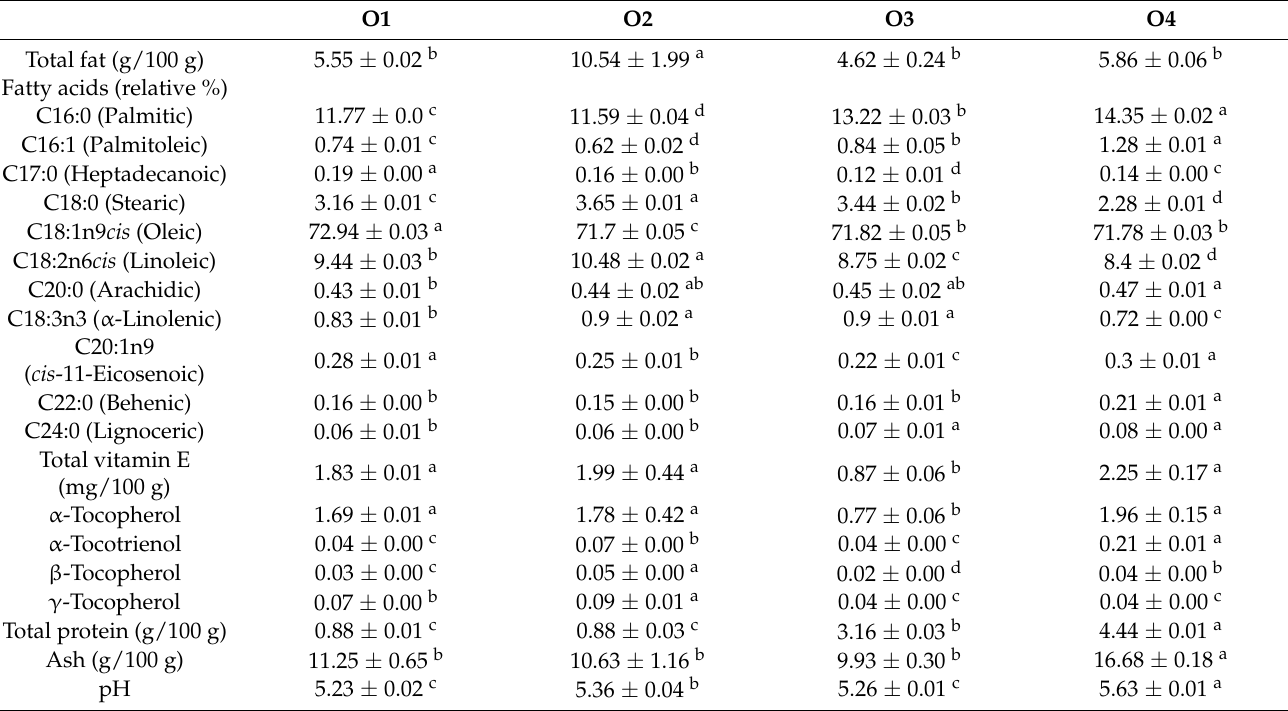
Table 5. Chemical analysis of the olive pomace ingredients (total fat, fatty acid and vitamin E profiles, total protein, ash and pH) (dry